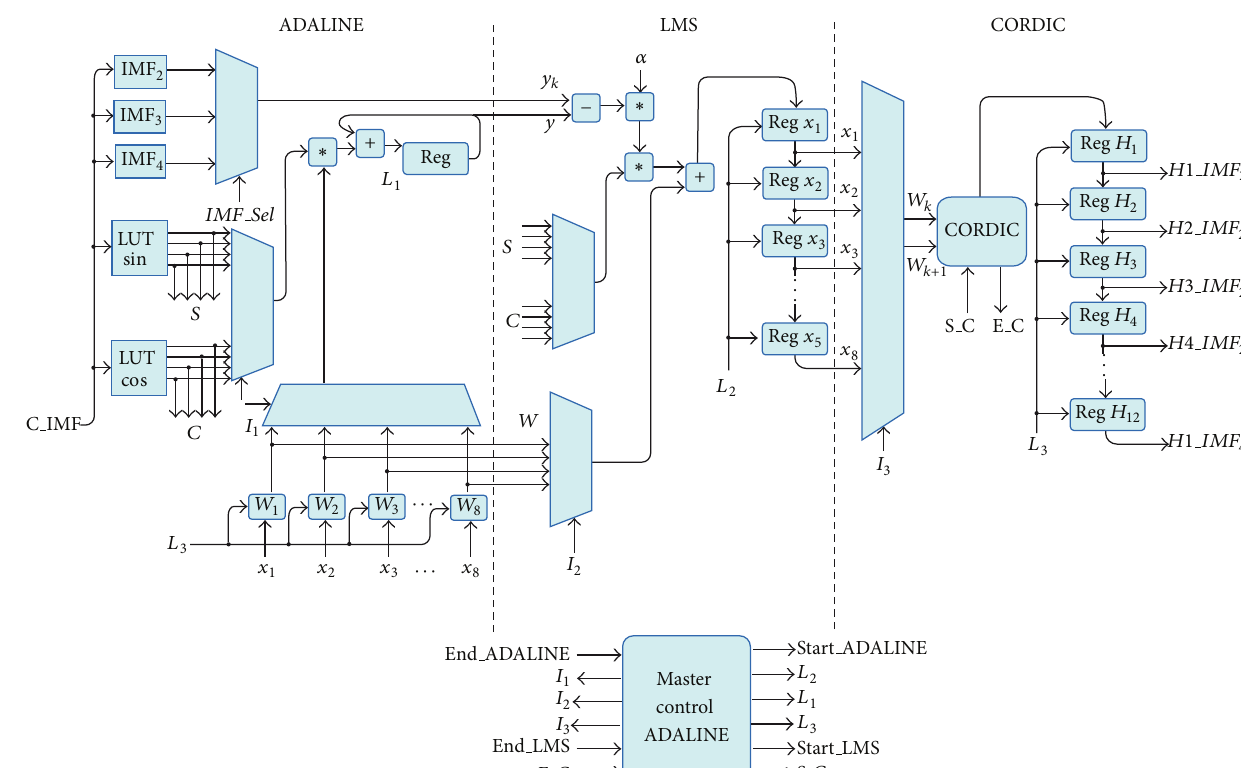
Figure 11: Block diagram of the ADALINE